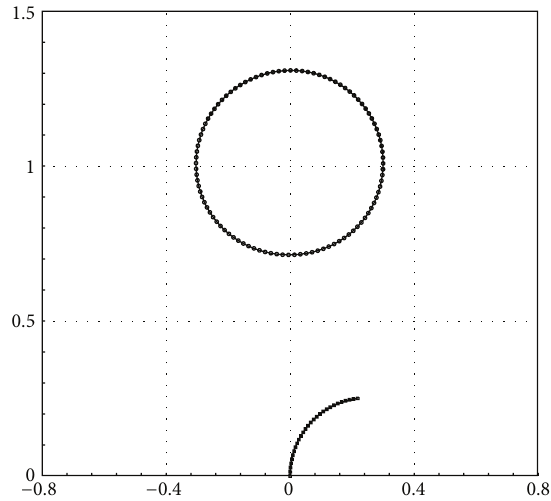
Figure11:Initialconfigurationsoftheflexibleboundariesimmersed in the square flow domain.